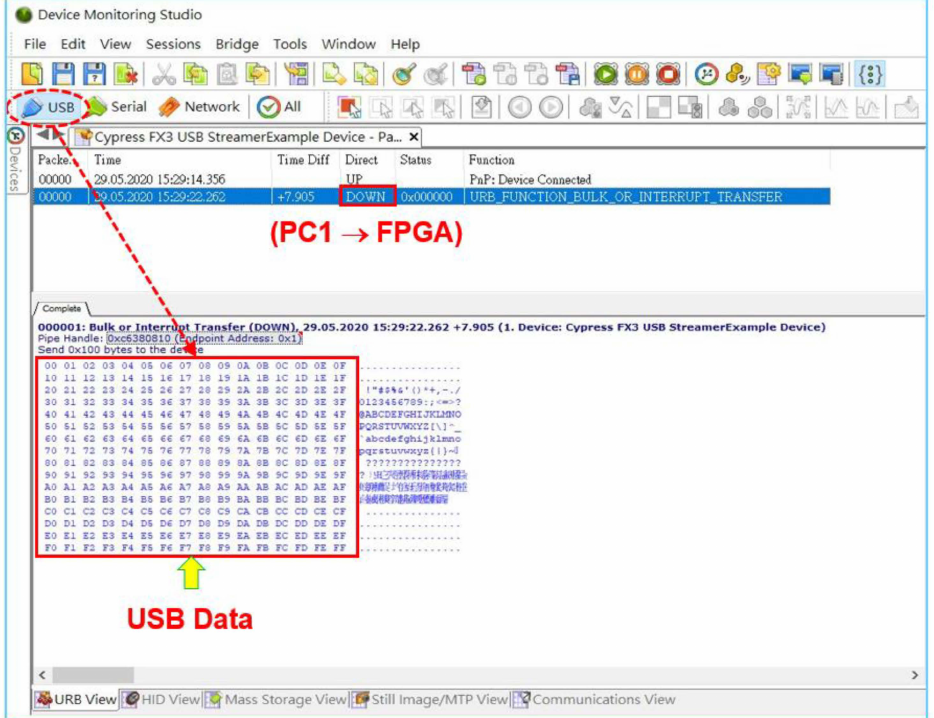
Figure 18. Received USB data from the PC1 to the FPGA development kit using USB device monitor- ing software (Device Monitoring